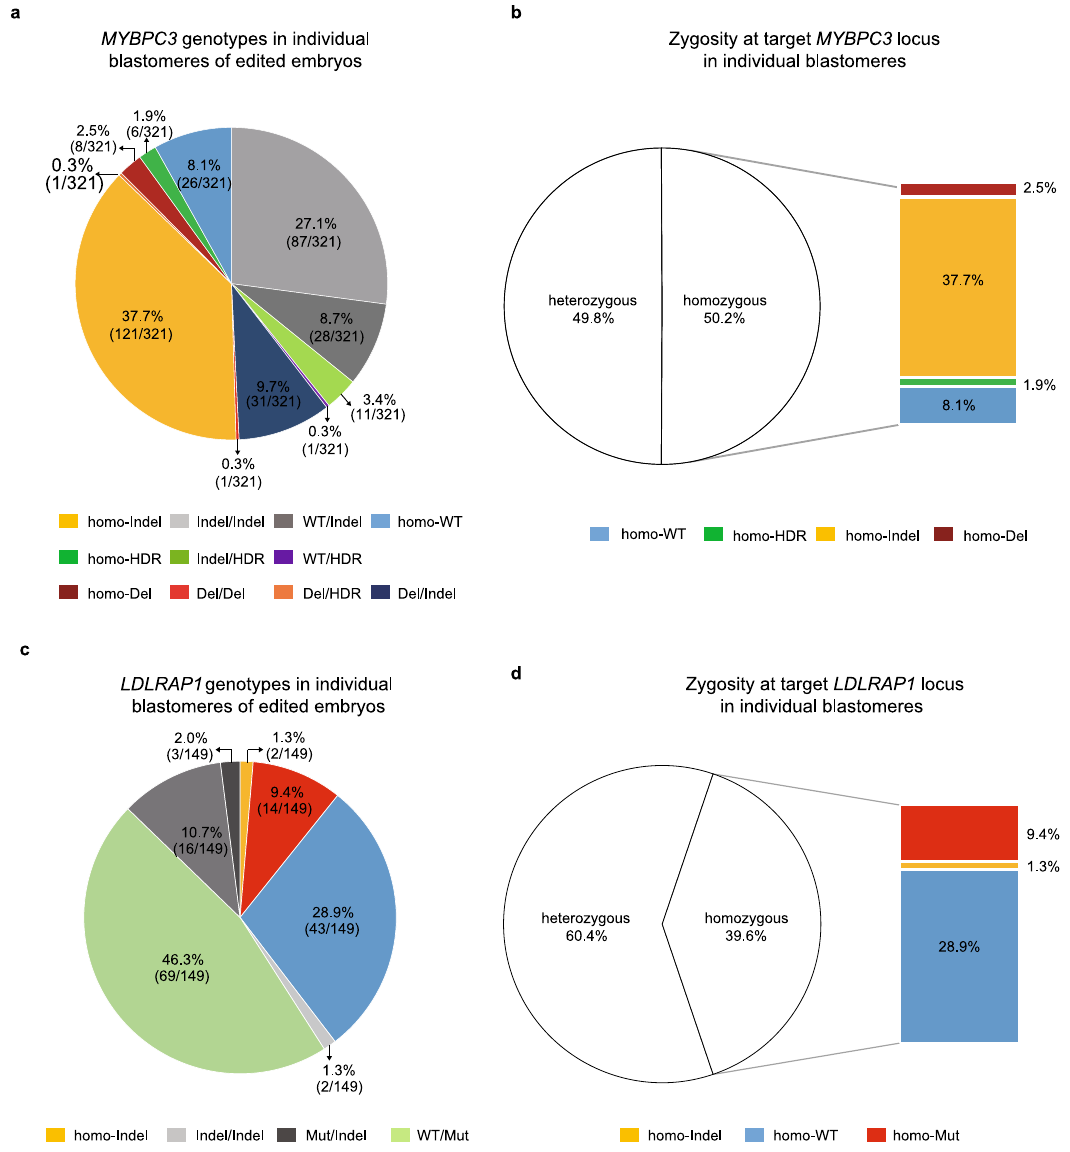
Fig.1|BiallelicDNADSBrepairat MYBPC3 locusofhumanembryos.a On-target MYBPC3 genotypes in individual blastomeres of human embryos injected with CRISPR/Cas9. b Zygosity at the target MYBPC3 locus in individual blastomeres of human embryos injected with CRISPR/Cas9. Note that a large proportion of blas- tomeres carried homozygous genotype locus due to LOH. c On-target LDLRAP1